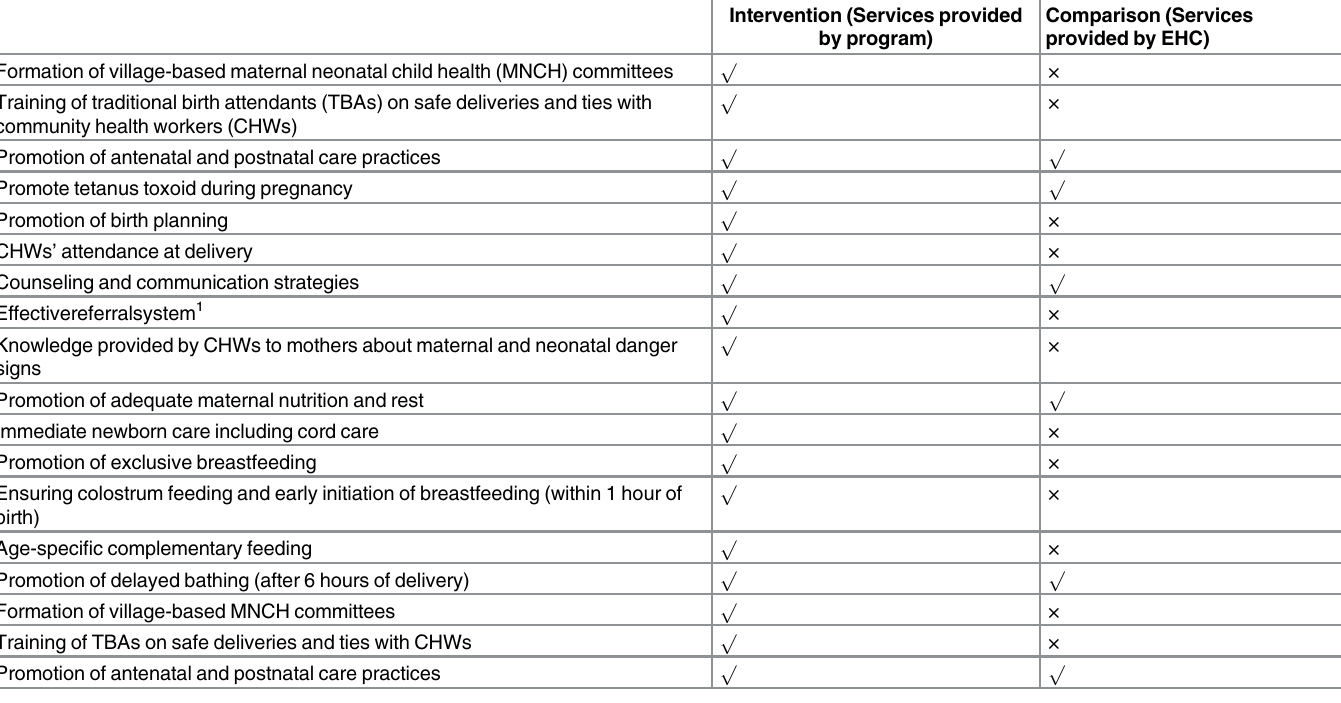
Table 1. Intervention package